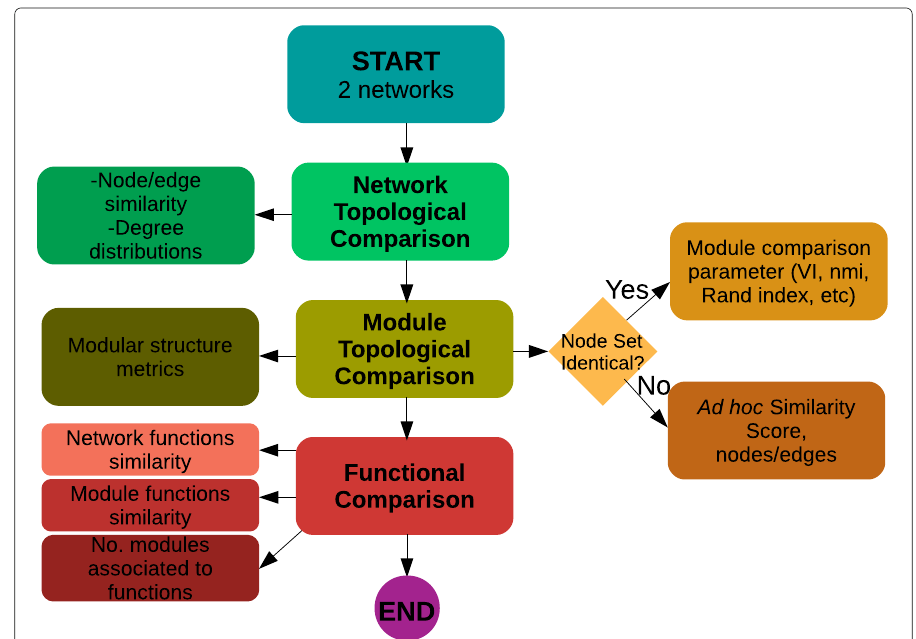
Fig. 2 Methodological pipeline for the comparison of modular structures in biological networks from a topological and functional